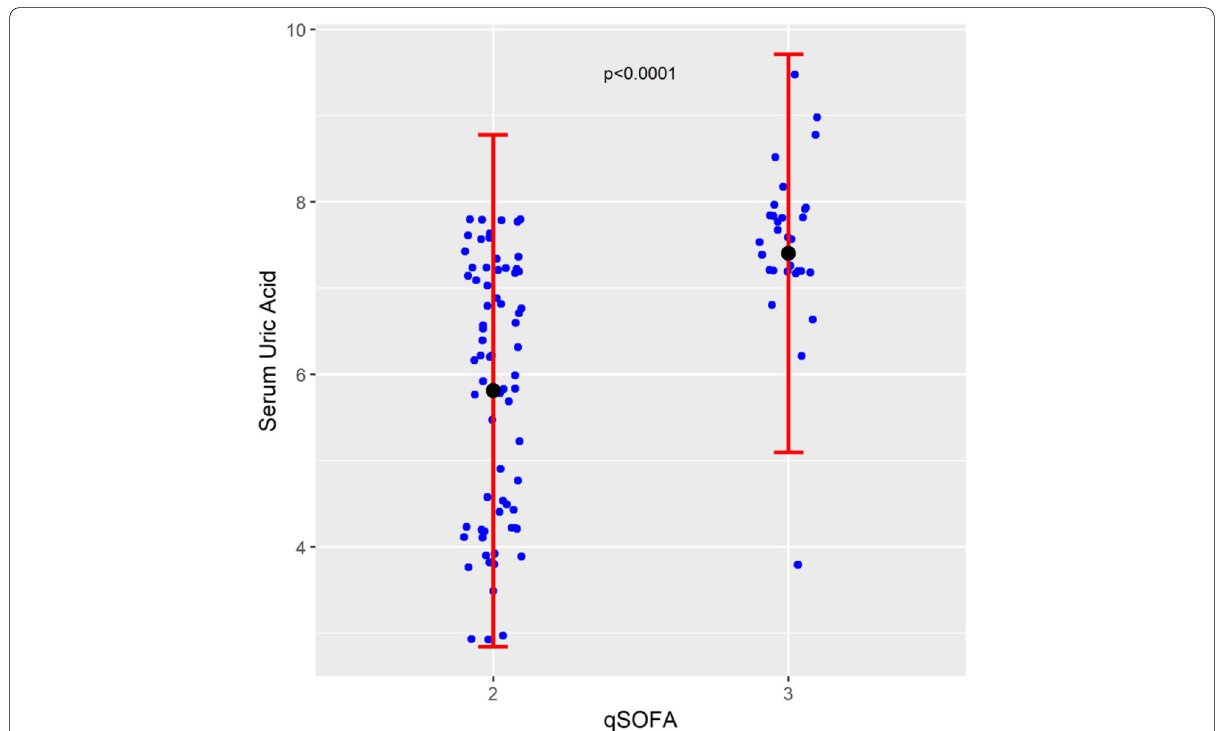
Fig. 1 Association of hyperuricaemia with